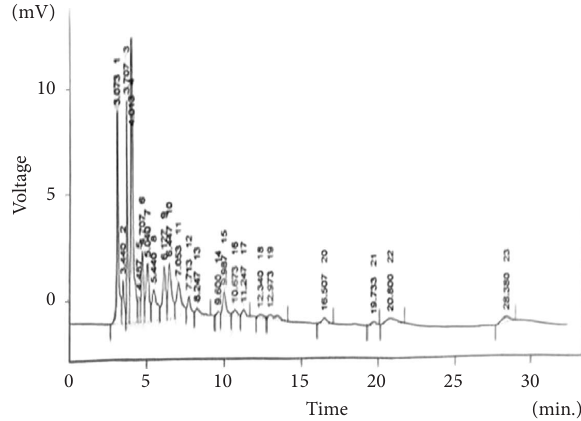
Figure 2: HPLC chromatogram of Trigonella foenum-graecum leaves.